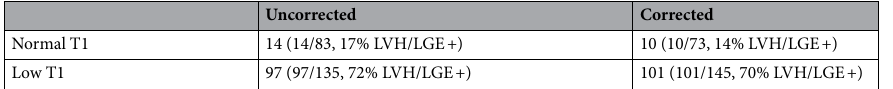
Table 4. Number and percentage of LVH/LGE + in uncorrected vs. blood corrected